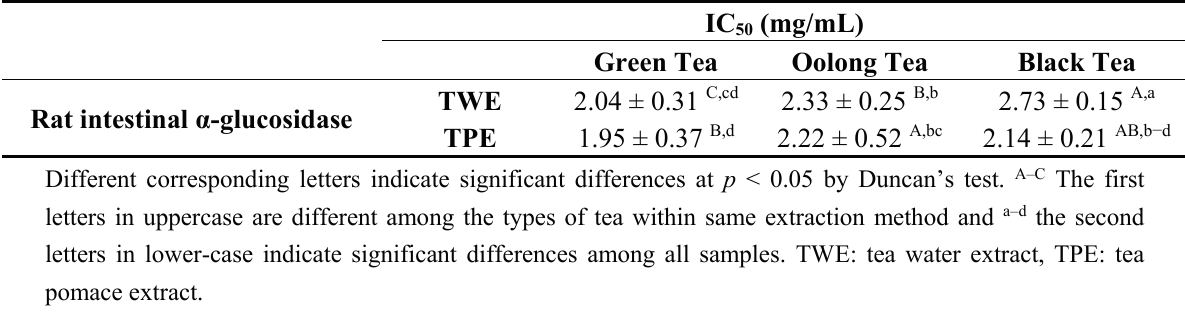
Table 1. Half maximal inhibitory concentration (IC 50 ) of tea extracts on rat intestinal α -glucosidase